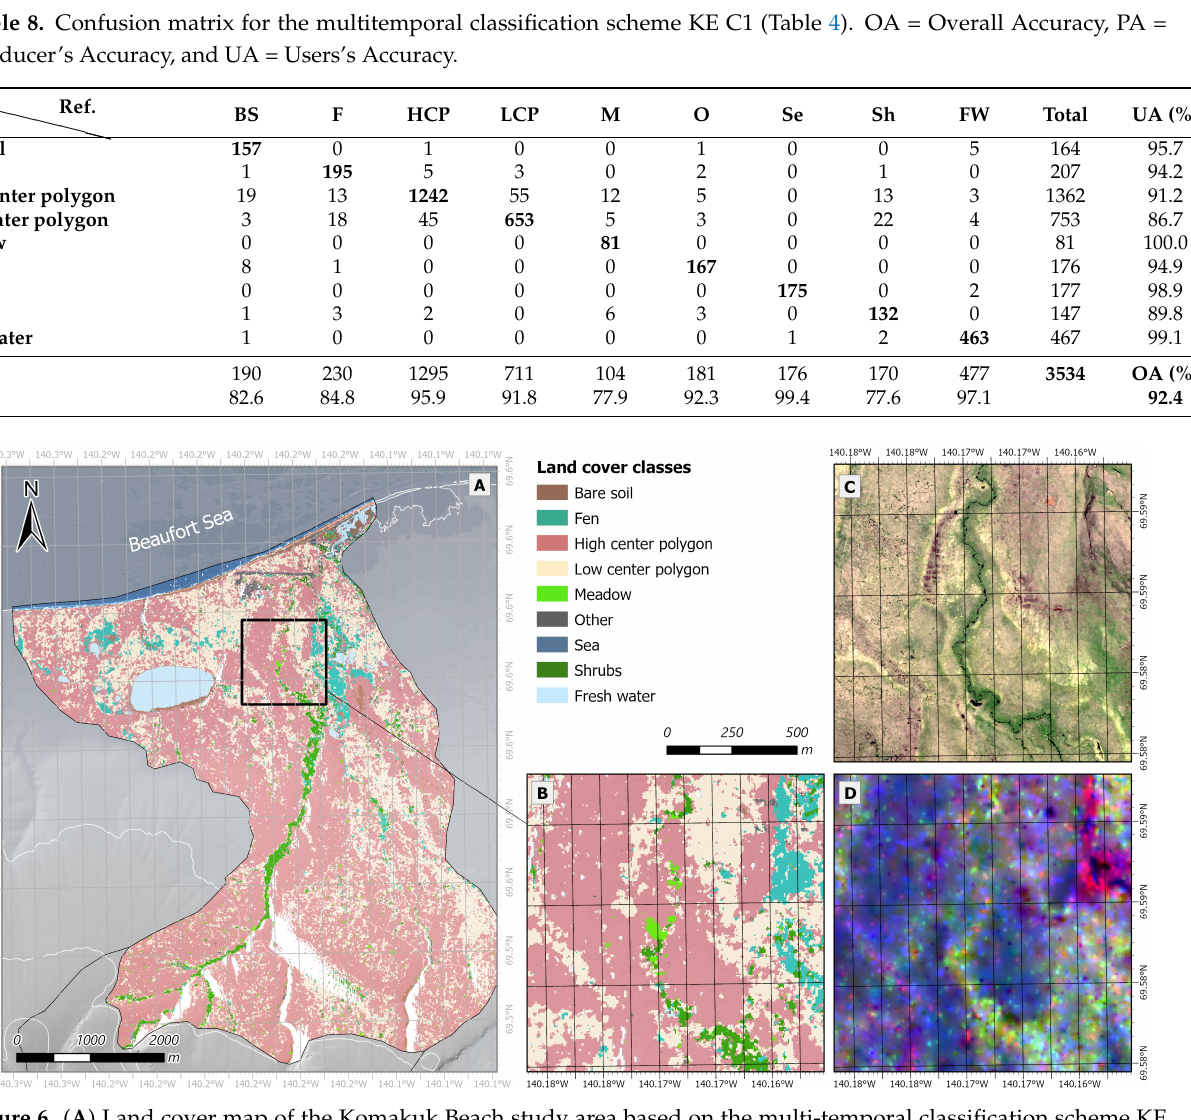
Figure 6. ( A ) Land cover map of the Komakuk Beach study area based on the multi-temporal classification scheme KE C1 (Table 4) [76]. DEM(s) courtesy of the Polar Geospatial Center [49]. ( B ) Subset of the KE C1 land cover map. ( C ) The subset with a WorldView-3 optical image. Imagery [2019] Digital Globe ©, Maxar Technologies, Westminster, CO, USA [50]. ( D ) The subset with a RGB-image of the best predictors derived from the TerraSAR-X timeseries with R = L5_k0_oct23, G = L7_k0_dec06, and B =